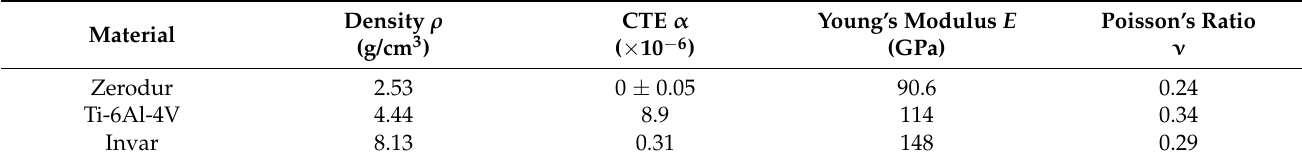
Figure 8. Mechanical structure of the mirror support system. Table 3. Material properties of the mirror assembly.